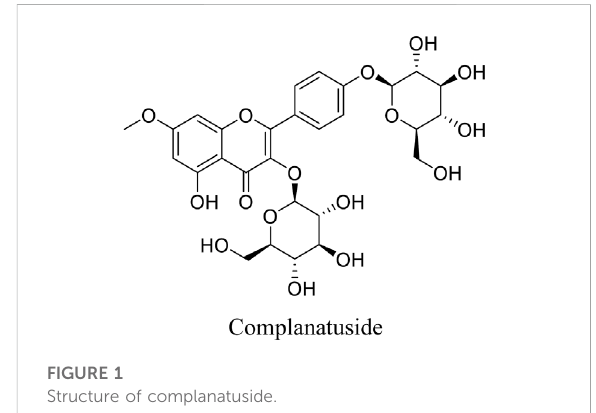
FIGURE 1 Structure of